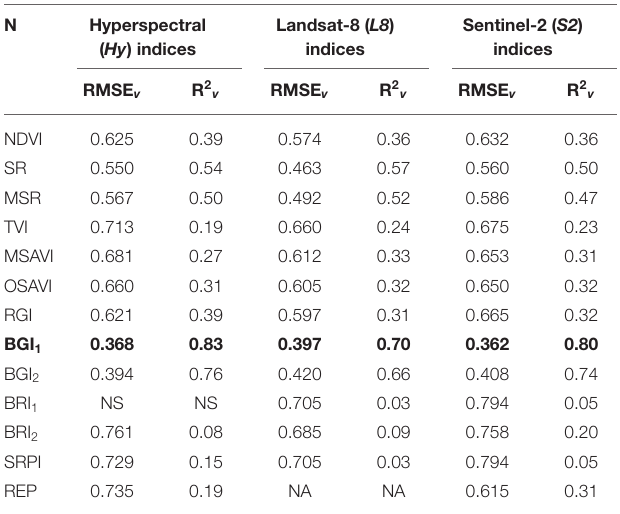
TABLE 9 | Validation statistics (RMSE v and R 2 v ) of simple linear regression models of Hyperspectral ( Hy ) indices, and synthesized Landsat-8 ( L8 ) and Sentinel-2 ( S2 ) indices obtained for N concentration of finger millet.